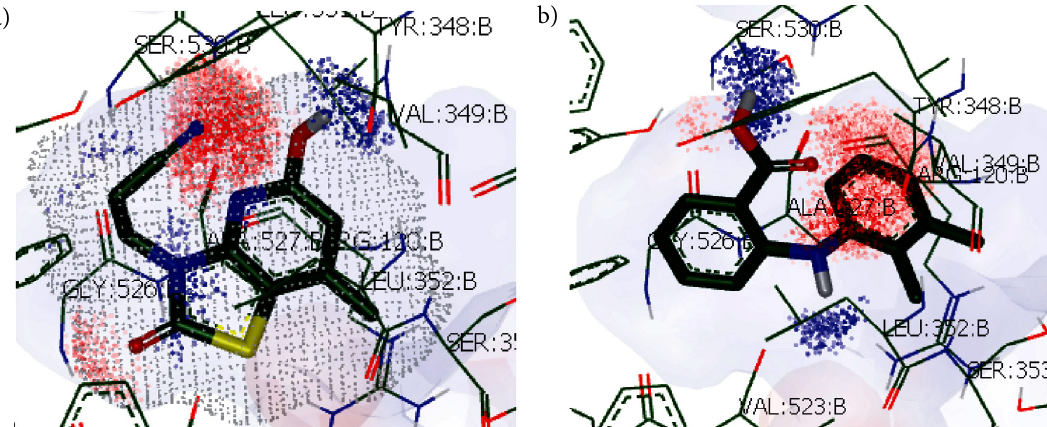
Figure 1. Compound 5 docked in the active site of COX-2 (a) in comparison with inhibitor mefenamic acid docked in the active site of COX- 2. (b)